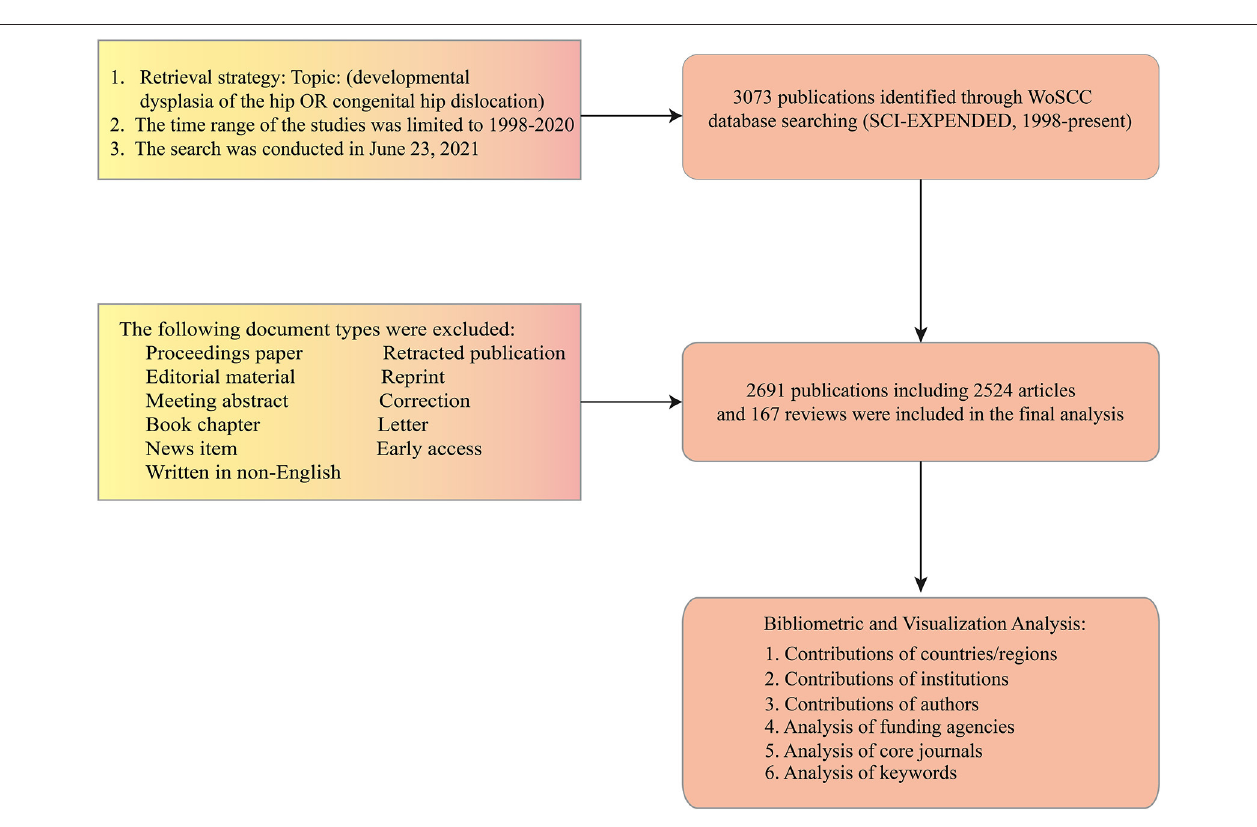
FIGURE 2 | Flowchart for the selection of literature included in the